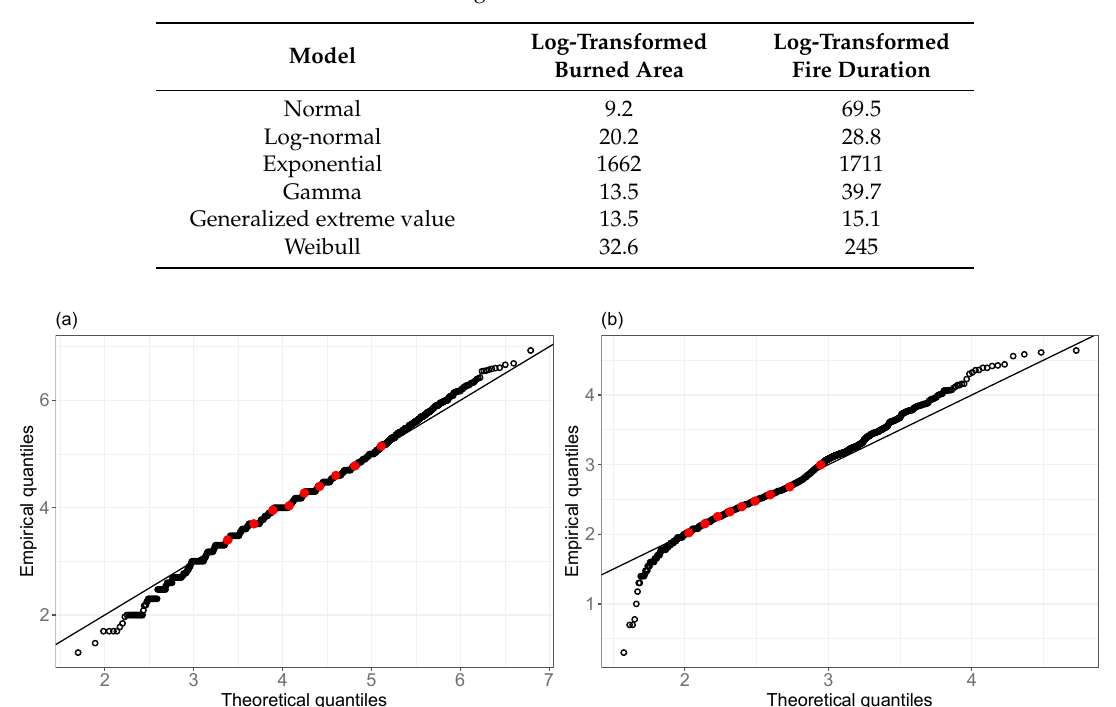
Table 3. Anderson-Darling distance values for all tested distributions.